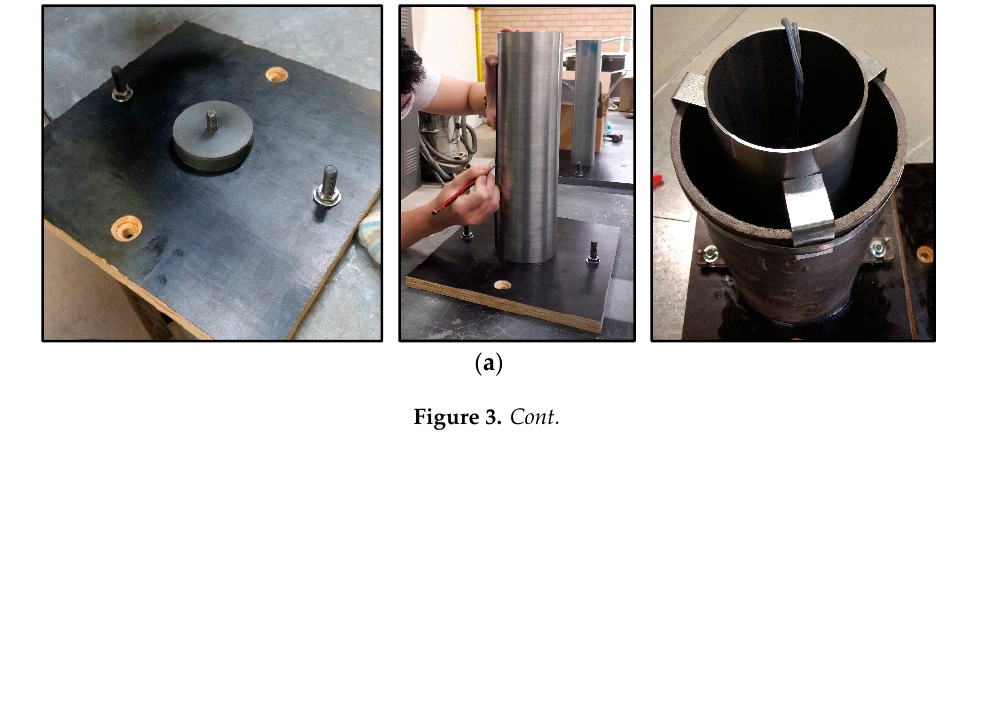
Figure 2. Cross-sectional dimensions of test columns.